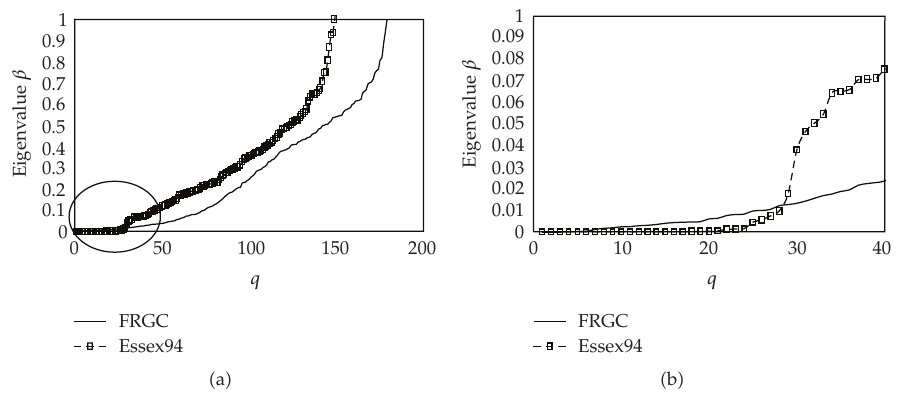
Figure 4: Typical real NPE-eigenspectra of (cid:2) a (cid:3) a complete set of eigenvectors and (cid:2) b (cid:3) the first q eigenvectors.